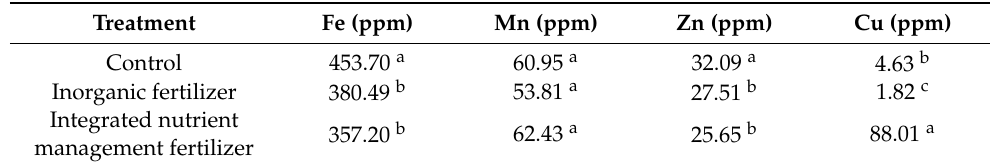
Table 5. Micronutrient concentration of Teucrium luteum subsp. gabesianum young plants treated with inorganic and integrated nutrient management fertilizers (control: no